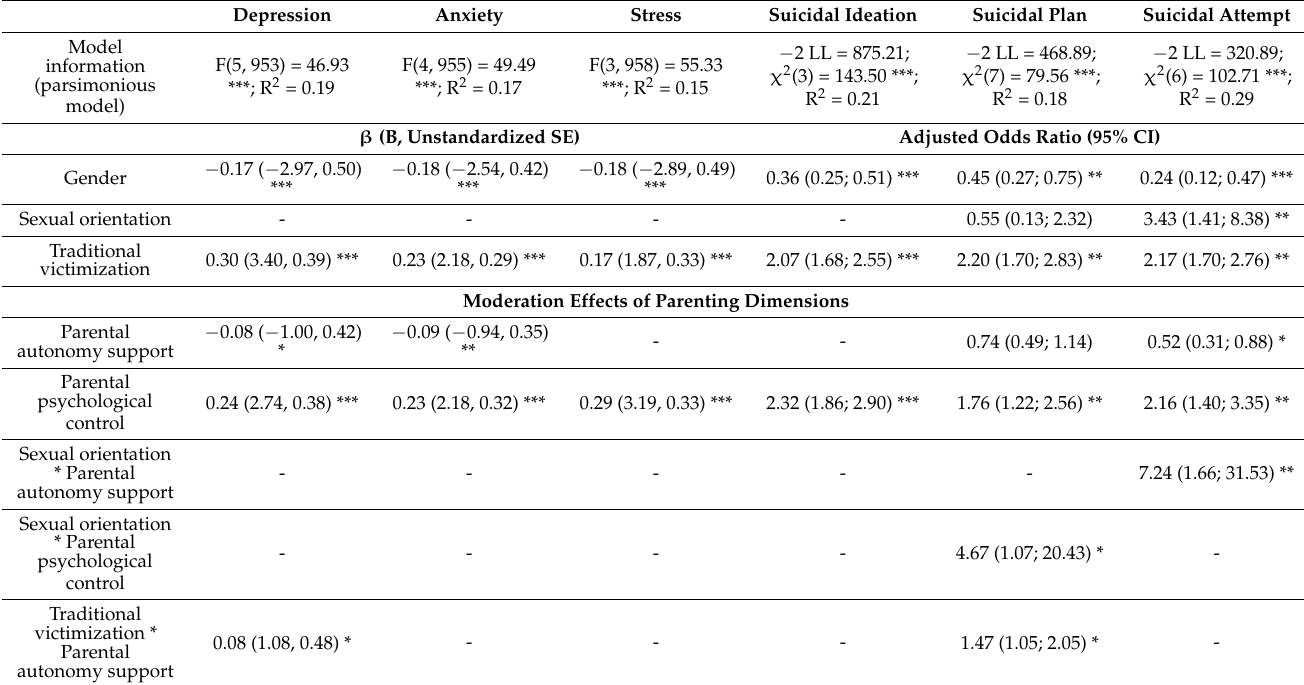
Table 3. Moderation analyses of parenting dimensions in the relationship between traditional bullying victimization and sexual orientation in negative mental health outcomes. Underline: It was used to more clearly indicate what the difference is between the two tables where one shows traditional bullying and the other